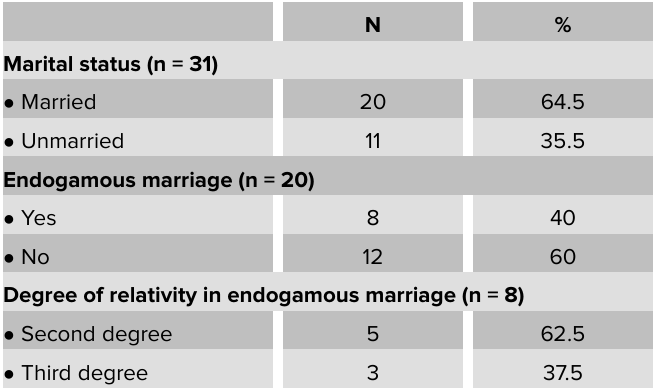
Table 3: Distribution of marital status, endogamous marriage and degree of relativity in endogamous marriage among the study